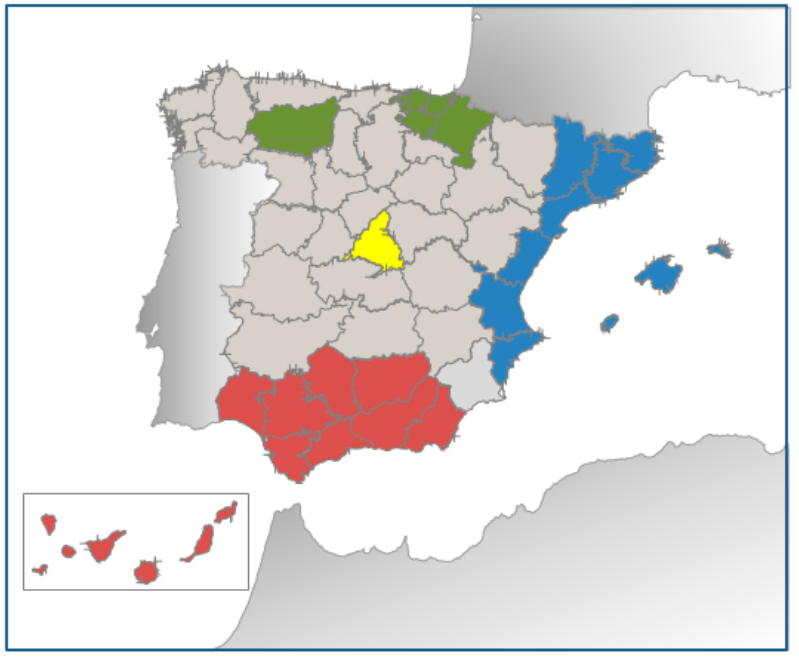
Figure 1. Map of Spain with the geographical areas analysed.